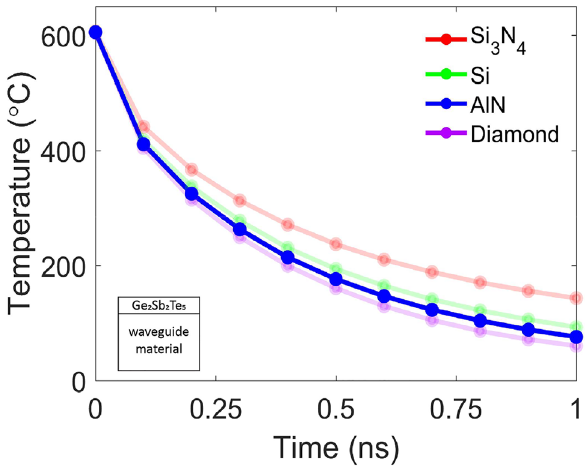
Figure2: TemperaturevariationoftheGe 2 Sb 2 Te 5 fi lmwithtimeasit cools. Figure inset shows the Ge 2 Sb 2 Te 5 /waveguide stack simulated. More information of the simulation parameters can be found in the Supplementary Material Section